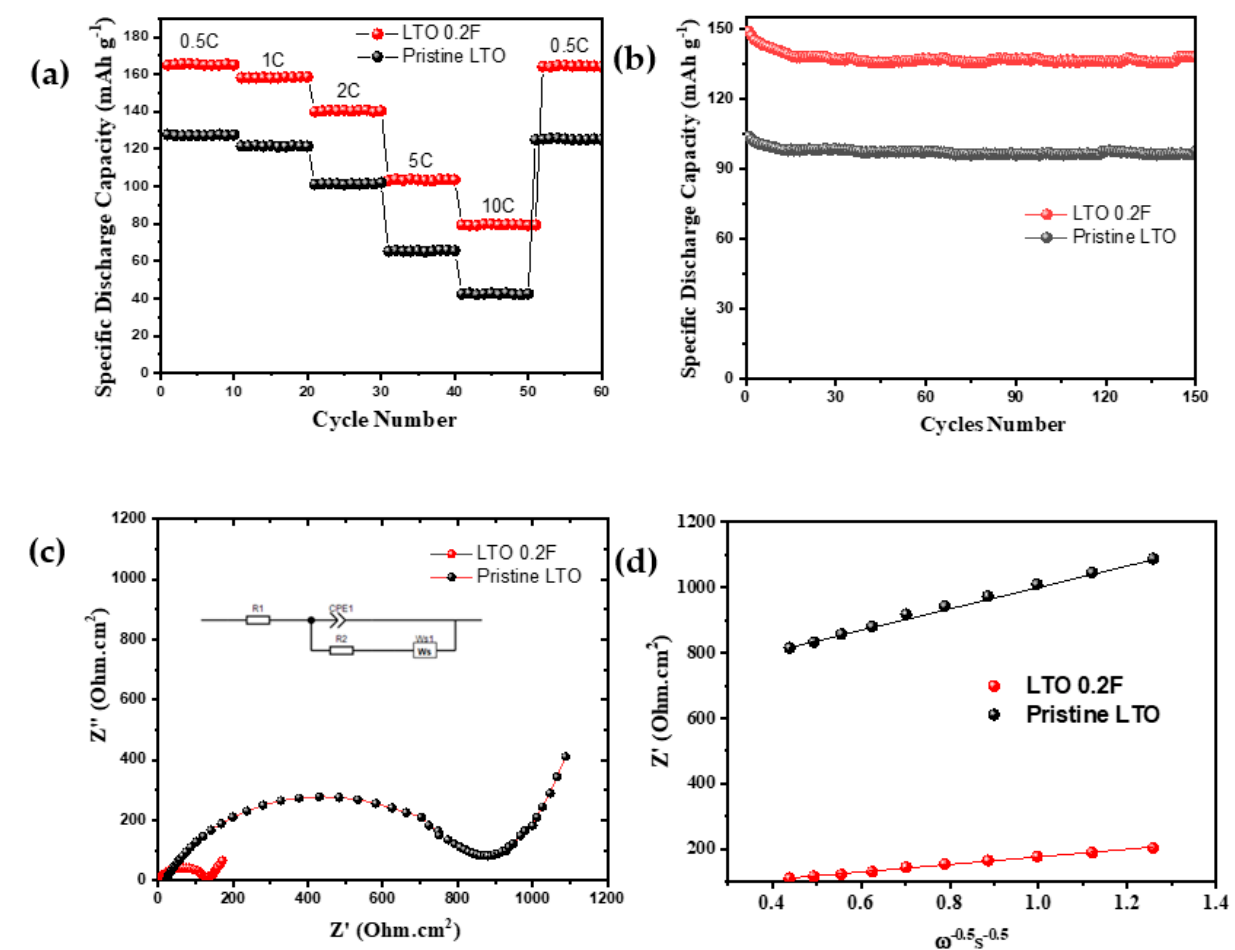
Figure 5. High − rate capability ( a ), cyclability ( b ), Nyquist plot with inserted equivalent circuit ( c ) and Li + diffusion profile ( d ) of pristine LTO and LTO 0.2F.